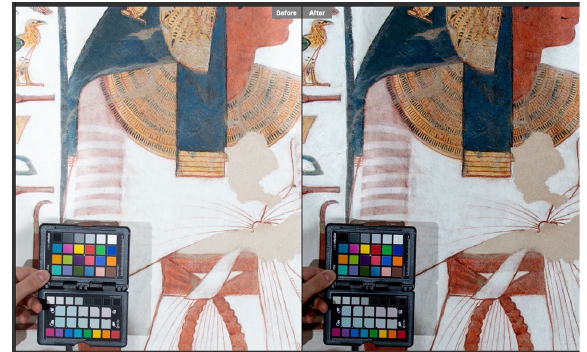
Figure 5. An example of post-processing white balance and exposure correction using an X-Rite ColorChecker® Passport in the Tomb of Nefertari survey before (left) and after (right) (Credit: Carleton Immersive Media Studio; Carleton University. © J. Paul Getty